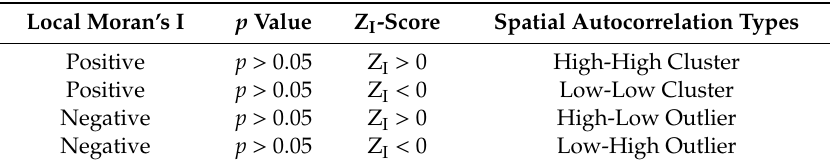
Table 3. Spatial autocorrelation types of LISA